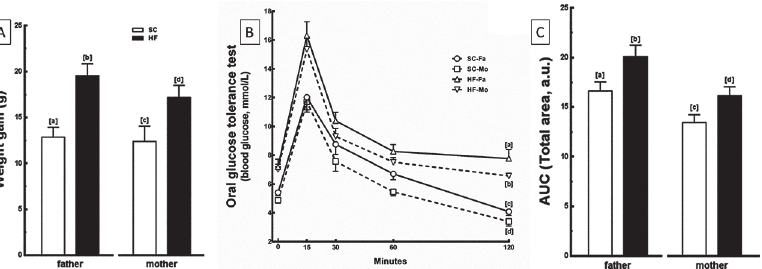
Fig 2. Parental data. (A) Pre-mating weight gain, (B) Oral glucose tolerance test (OGTT) and (C) Area under the curve (AUC) from OGTT of fathers and mothers. Data are expressed as the mean and SD for n = 5 mice per group in all analyzes (one way ANOVA and the posthoc test of Holm-Sidak). Same letters represent equal groups with no statistical difference while different letters represent different groups from each other, with statistical difference (P < 0.05). Abbreviations: father that received standard chow (SC-Fa); father that received high-fat diet (HF-Fa); mother that received standard chow (SC-Mo); mother that received high-fat diet (HF-Mo); area under the curve (AUC) and arbitrary units (a.